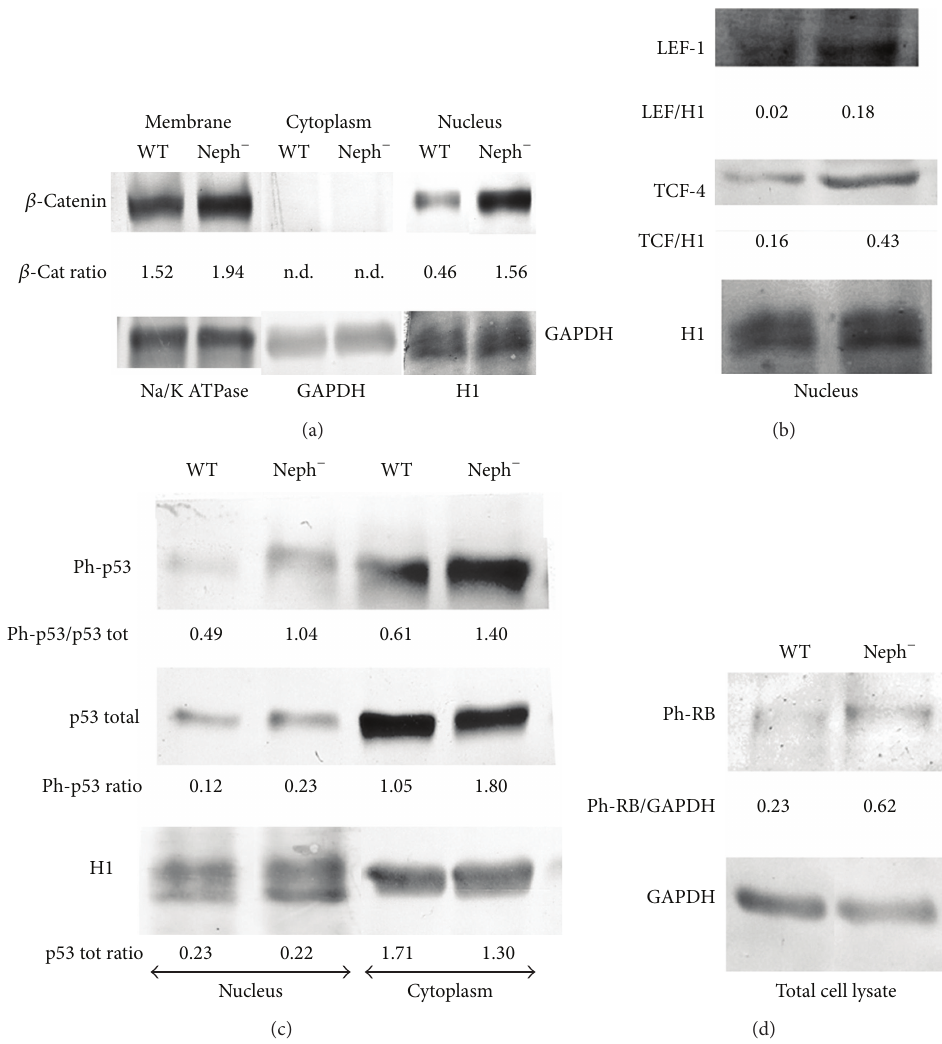
Figure 5: 𝛽 -Catenin, TCF-4, LEF-1, p53, and pRB distribution and expression in wild type and nephrin-mutated podocytes. The cells were lysated, fractionated and processed for western blot as described in Section 2. (a) Distribution and expression of 𝛽 -catenin in cell membranes and nuclear compartment. The goat anti- 𝛽 -catenin (sc-1496) antibody was purchased from Santa Cruz Biotechnologies (Santa Cruz, CA, USA). (b) Expression of LEF-1 and TCF-4 in nuclear compartment. The goat anti-LEF-1 (sc-8591) and anti-TCF-4 (sc-8631) antibodies were purchased from Santa Cruz Biotechnologies (Santa Cruz, CA, USA). (c) Phosphorylated and total p53 distribution and expression in nucleus and cytoplasm. The mouse monoclonal anti-p53 IC12 (no. 2524) and the rabbit polyclonal anti-Phospho-p53 (ser15) (no. 9284) antibodies were purchased from Cell Signaling Technologies (Boston, MA, USA). (d) Phosphorylated-RB expression in total cell lysate. The rabbit anti- phospho-RB (ser780) (no. 9307) antibody was purchased from Cell Signaling Technologies (Boston, MA, USA). To quantify the protein bands, we scanned the blots and performed a densitometry analysis, using the software NIH ImageJ v. 6.4 (freeware, NIH, MD, USA). Where the relative amount of protein is indicated as generic “ratio” instead of ratio to a specific housekeeping protein, it is because the protein quantization referred to the different cell compartment housekeepers indicated at the bottom of each blot. The figure shows a typical experiment of at least three performed under the same